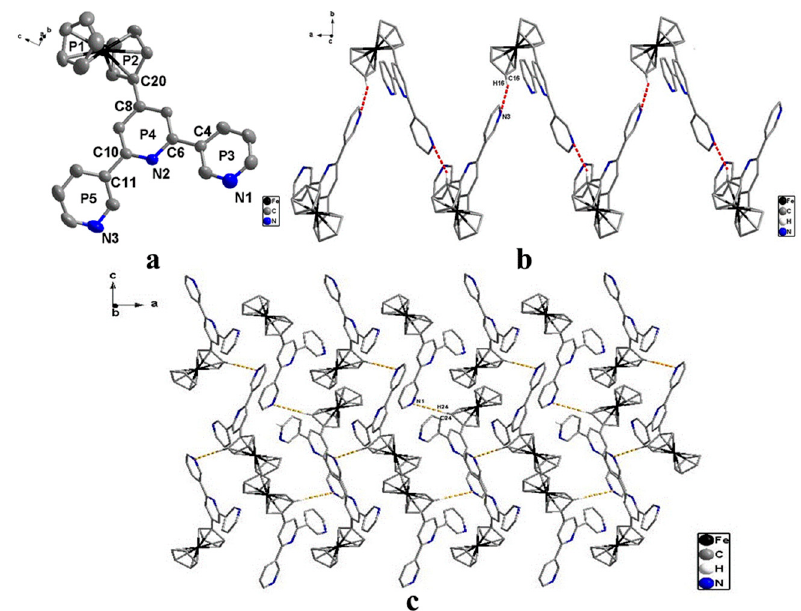
Figure 3. The structure of the ligand. ( a ) Atom part numbering and ring labelling (H atoms are omitted for clarity); ( b ) One-dimensional (1D) chain interacted through C–H ··· N (red dotted lines) of L (along the a axis); ( c ) Two-dimensional (2D) networks interacted through C–H ··· N (yellow dotted lines) of L (along the c